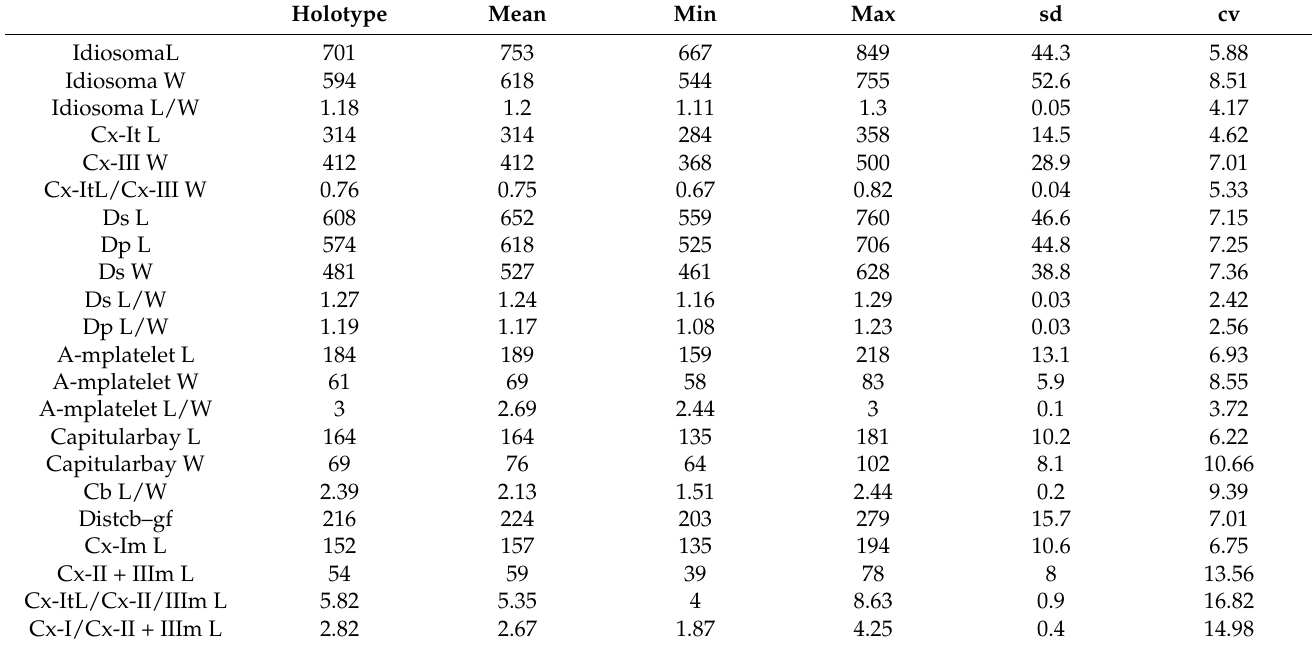
Table 3. Statistics of characters of Torrenticola costaricense that were derived from the analysis of 46 male specimens. In the last column, I have added the cv values for these characters (for an explanation of the abbreviations of the characters, see